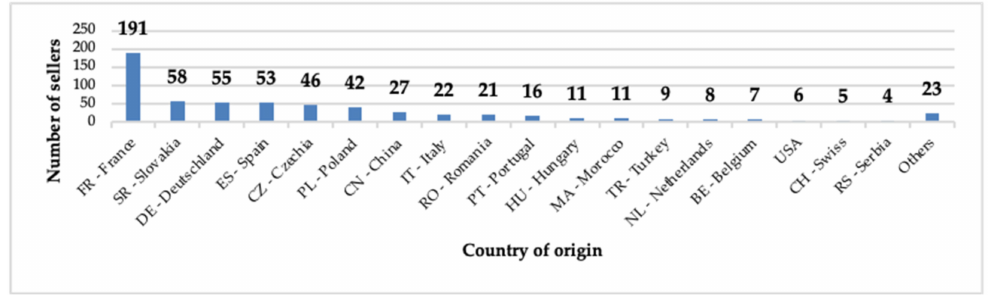
Figure 6. Supply chain for Citroen C3 and Peugeot 208 (2020). Source: Authors’ compilation.